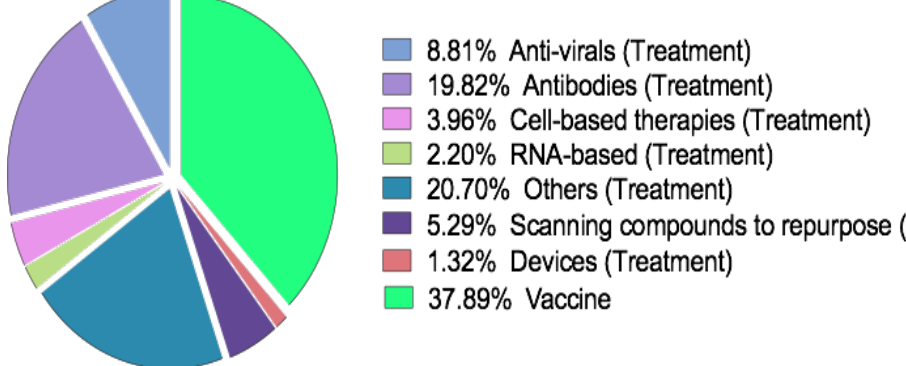
Figure 1. Coronavirus disease 19 (COVID-19) treatments and vaccines in a research pipeline with a percentage distribution.